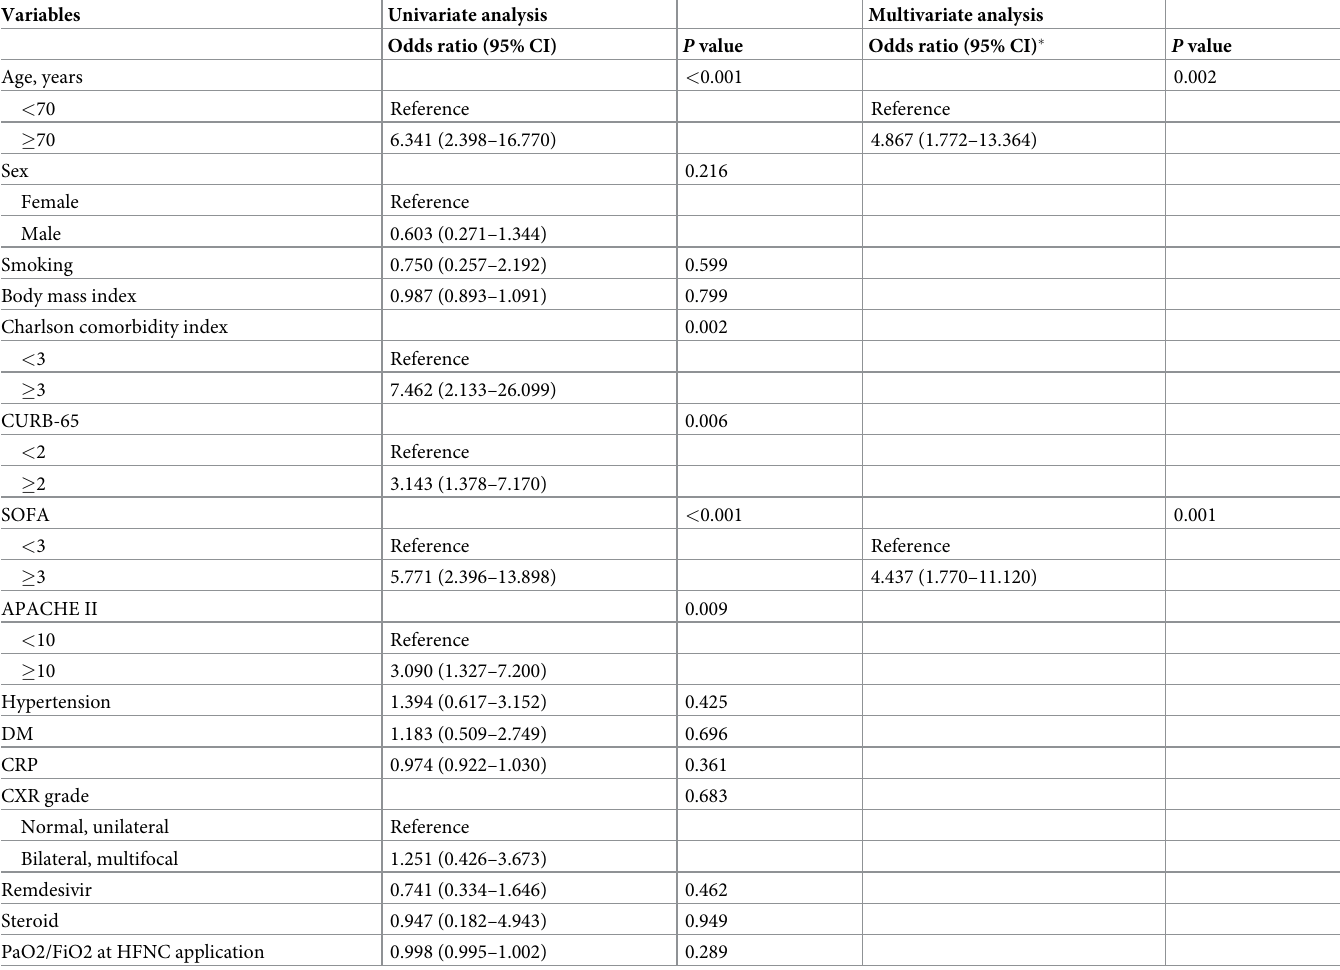
Table 4. Univariate and multivariable analyses of the predictive factors for in-hospital